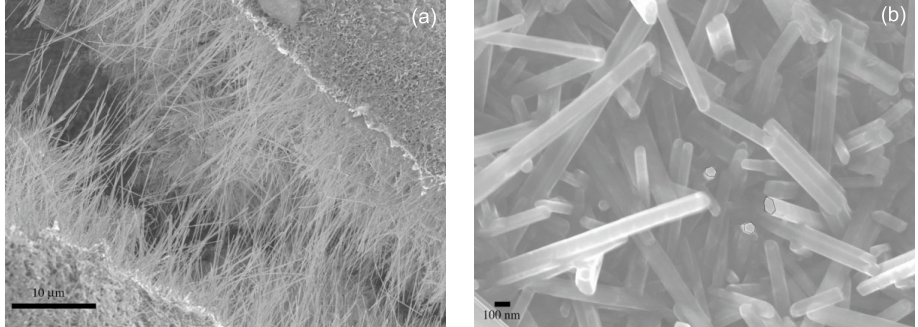
Figure 7. SEM images of the MgB 2 nanowires. ( a ) A thick mesh of nanowires; ( b ) Higher-magnification image of the vertically oriented nanowires [79].